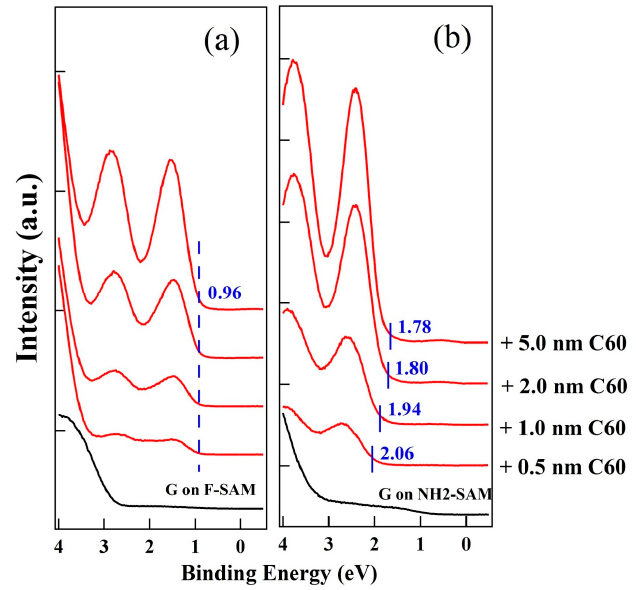
Figure 5. UPS spectra for the growth of C 60 on ( a ) graphene / F-SAM and ( b ) graphene / NH 2 -SAM.